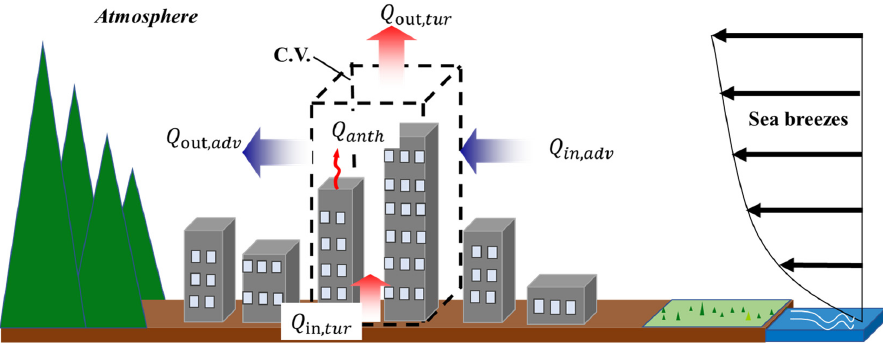
Figure 1. Concept of the heat balance mechanism in an urban space [1,18]. In Figure 1, 𝑄 (cid:3036)(cid:3041),(cid:3028)(cid:3031)(cid:3049) and 𝑄 (cid:3036)(cid:3041),(cid:3047)(cid:3048)(cid:3045) are the incoming sensible or latent heat fl ux by ad-